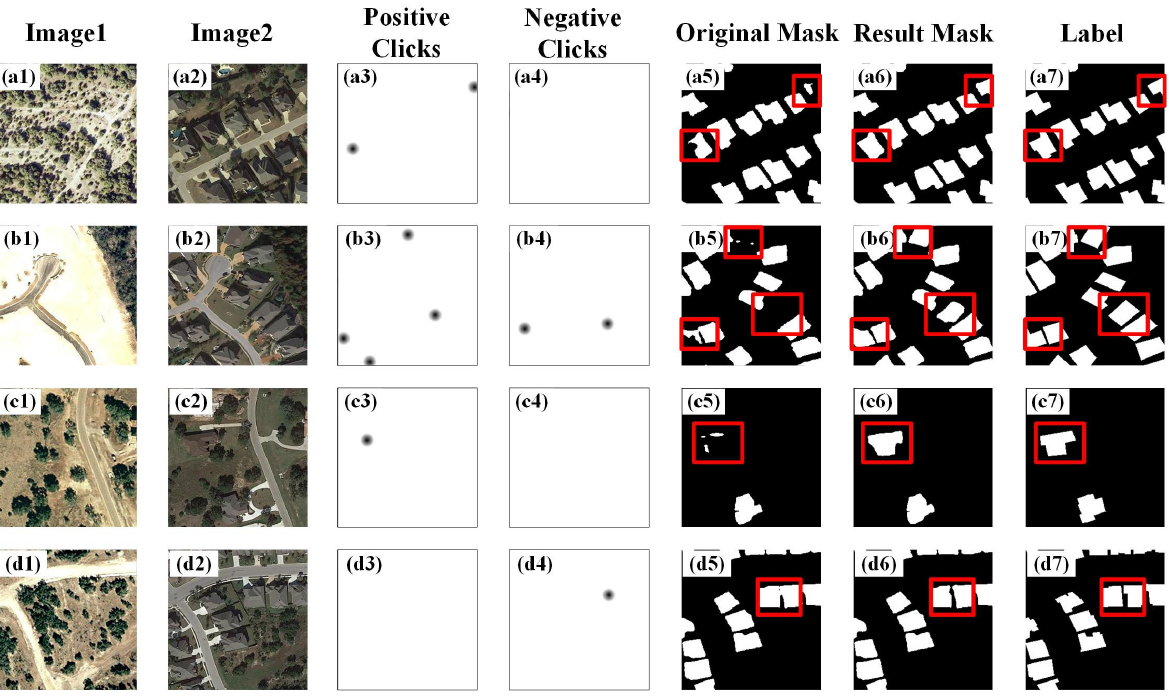
Figure 10. Correction results of ICD on the LEVIR-CD dataset. Column Image1 : phase 1 image; Column Image2 : phase 2 image; Column Positive Clicks : positive clicks; Column Negative image; Column Image2 ( a2 – d2 ): phase 2 image; Column Positive Clicks ( a3 – d3 ): positive clicks; Clicks : negative clicks; Column Original Mask : original predict results; Column Result Mask : the correction results; Column Label : ground truth. Column Negative Clicks ( a4 – d4 ): negative clicks; Column Original Mask ( a5 – d5 ): original predict results; Column Result Mask ( a6 – d6 ): the correction results; Column Label ( a7 – d7 ): ground